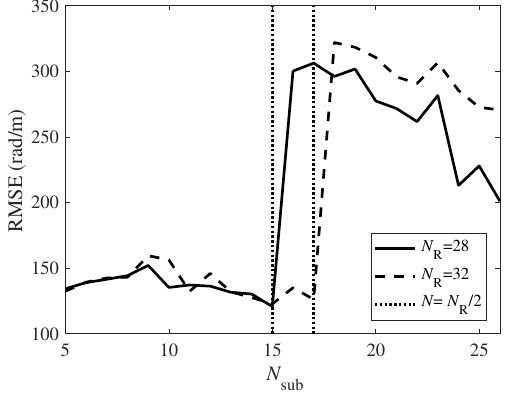
Figure 3. Dependence of the proposed method on sub-array size. The black solid line and the dotted line show the results for arrays composed of different numbers of receivers. The vertical black dotted lines show the horizontal values with N = N R /2, i.e., N sub − 1 = N R